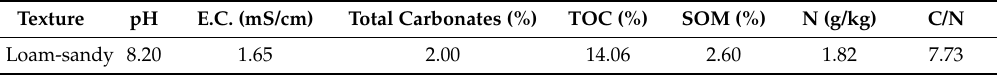
Table 1. Chemical and physical characteristics of field for Jatropha curcas L. cultivation.